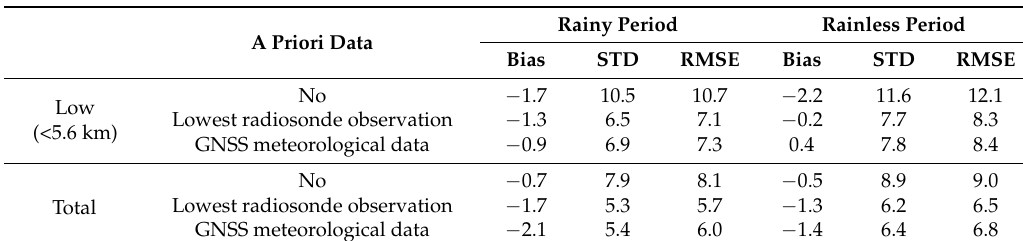
Table 2. Statistics of the tomography accuracy with respect to ECMWF data during a rainy period and a rainless period in 2015. unit: mm/km.